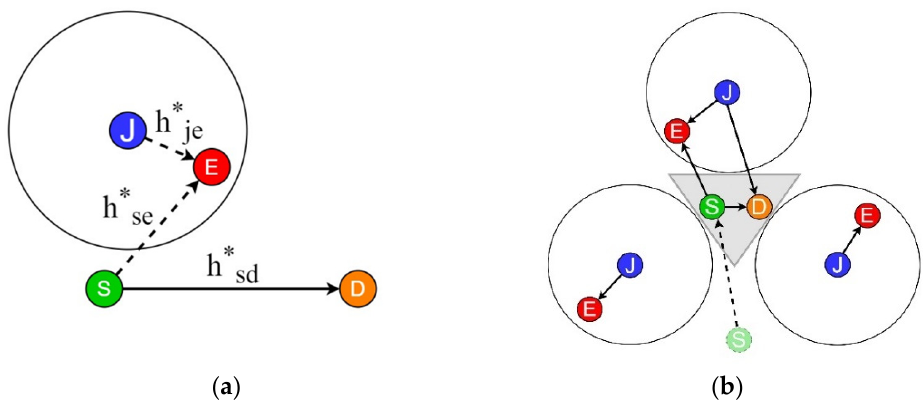
Figure 1. Network configuration for friendly jamming: ( a ) friendly jamming model and ( b ) CFJ- DMZ model.